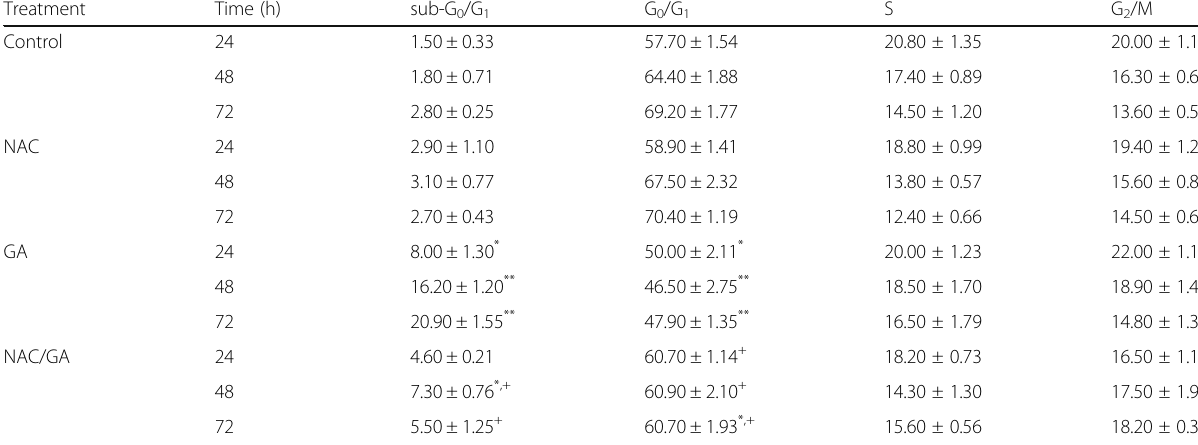
Table 2 Flow cytometric analysis of cell cycle distribution in HeLa cells treated with GA (in %). The results are presented from 3 independent experiments as mean ± SD; significantly different, * P < 0.05, ** P < 0.01 versus untreated cells (control); + P < 0.05 versus GA. Sub-G0/G1 fraction of cells identified as apoptotic population